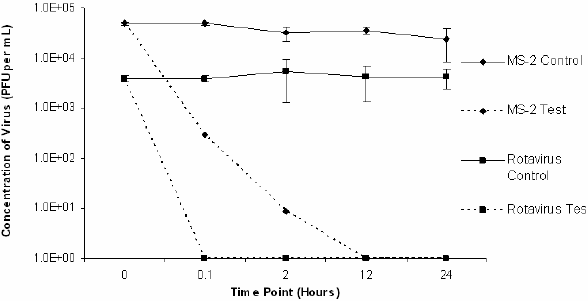
Figure 4: Average rotavirus Wa and MS2 inactivation in sludge matrices (compost, raw and previously limed) lime stabilized at room temperature (22 ± 5°C).